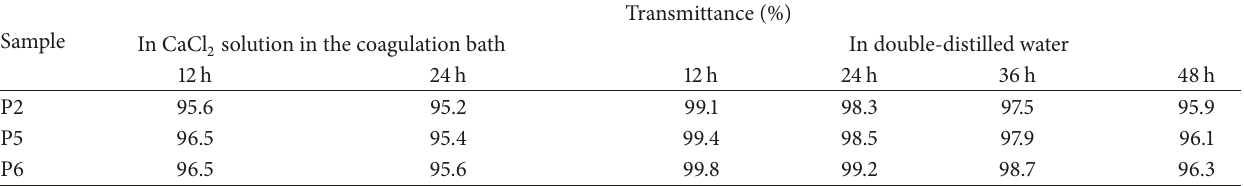
Table 2: Transmittance values of the aqueous media where particles without yeast have been preserved for different time durations.